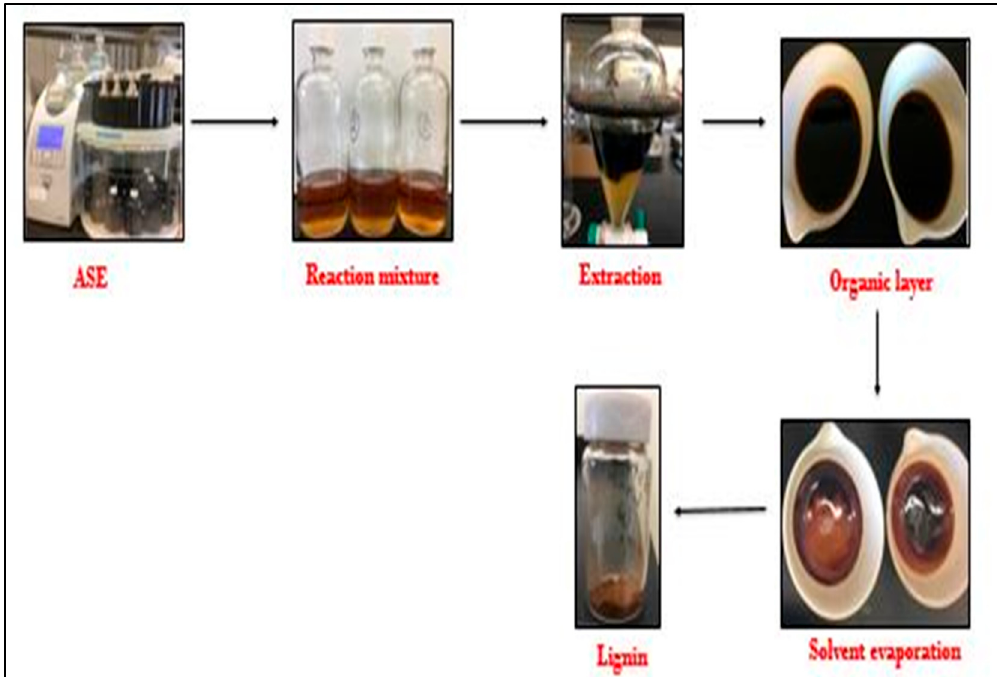
Figure 1. Extraction of lignin from the biomass using accelerated solvent extraction (ASE).